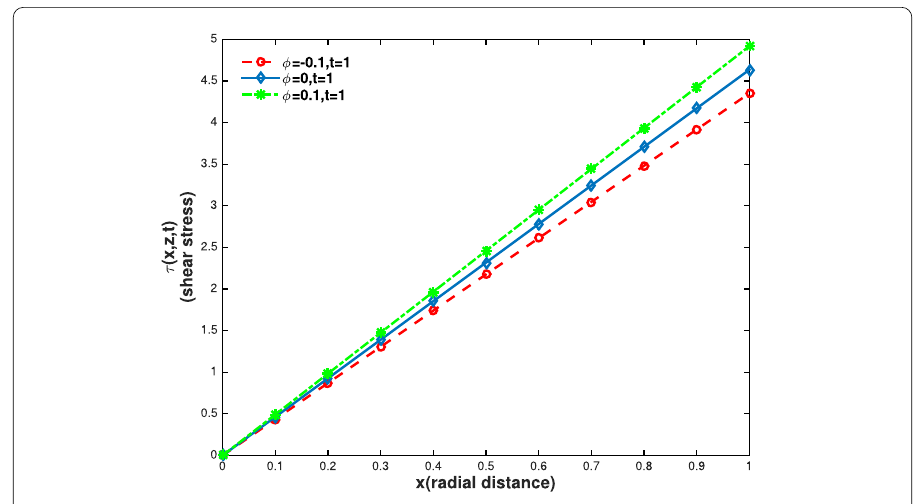
Figure 2 Shear stress vs radial distances for φ = –0.1,0,0.1 at z = 28, t = 1, τ y = 0.4, K = 1.6